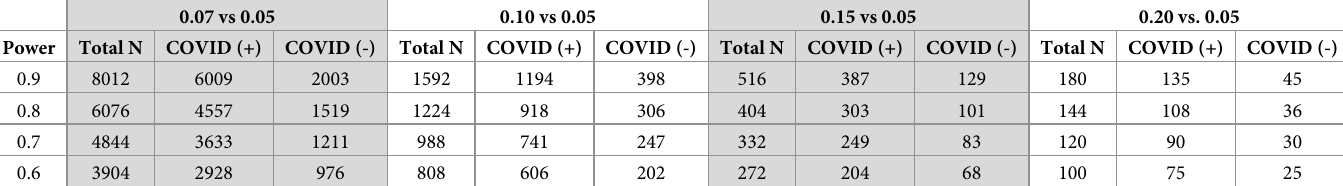
Table 4. Event rate difference between